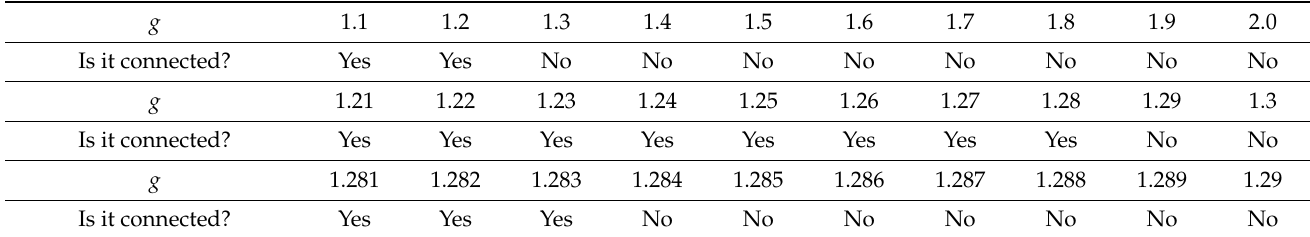
Table 3. Connectivity of the membership function with different values of g .